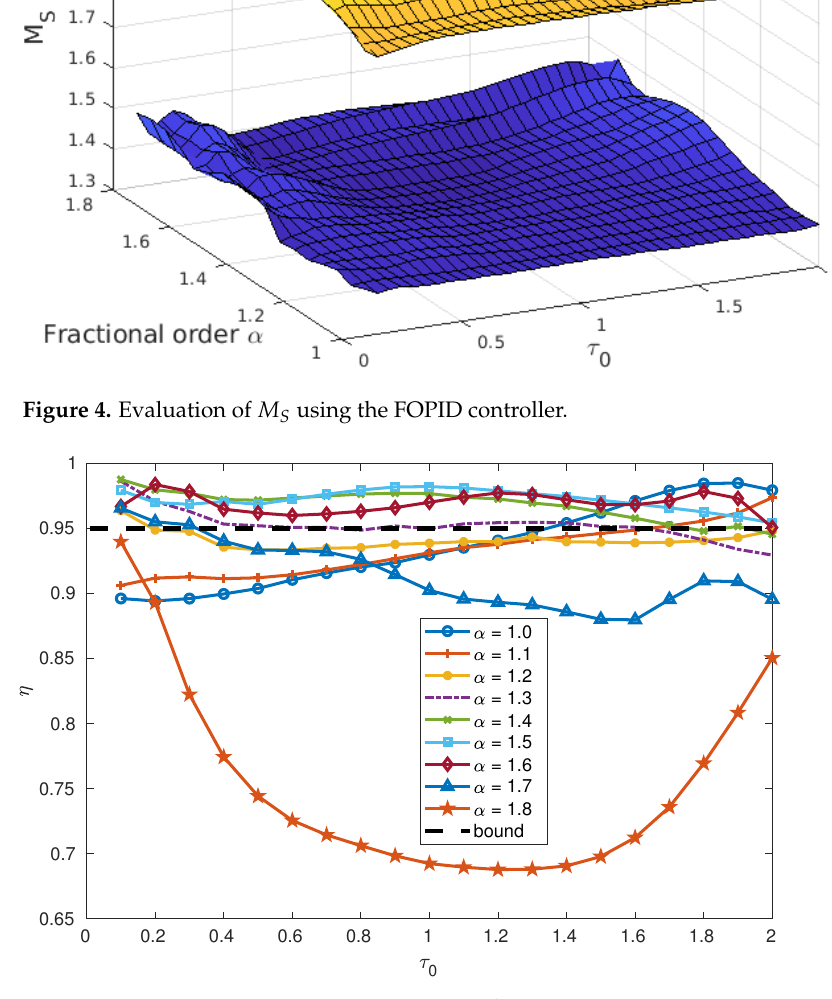
= 1.4. Figure 5. Index η for FOPID controllers with M t S = 2.0 is shown in Figure 6. As in the case M t = 1.4, some The index η for M t S S regions can be defined where the increase in the performance provided by the use of the FOMCoRoT method for FOPID over the optimal performance obtained with PID controllers is larger than or equal to 5%. The first region is characterized by α = 1.8 and τ 0 ≥ 0.4, and an improvement in the performance of up to 34% can be achieved. The second region is defined by α = 1.7 and τ 0 ≥ 0.6, and in this case, the improvement can reach values of 21%. The third region is for α = 1.6 and τ 0 ≥ 1.2, with an amelioration of up to 11% in the J t